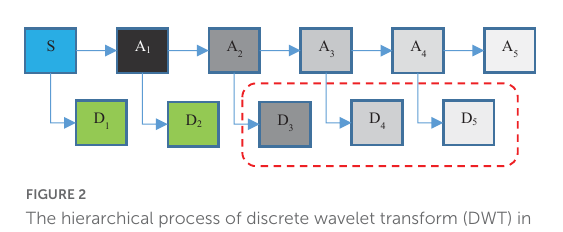
FIGURE2 The hierarchical process of discrete wavelet transform (DWT) in proposed